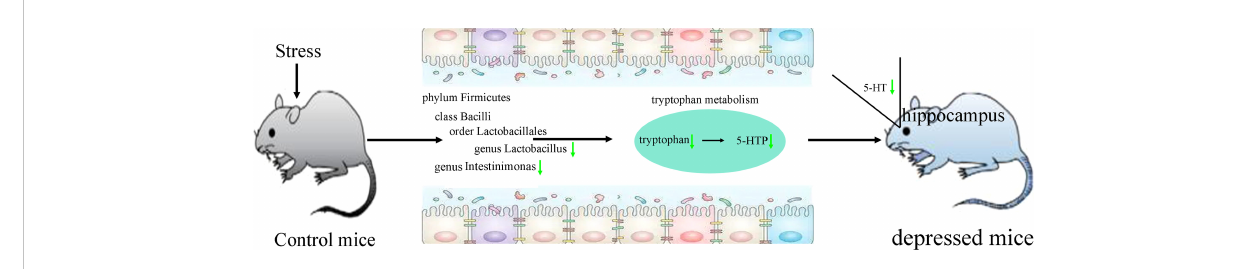
FIGURE 7 Tryptophan metabolism acting as a bridge in the crosstalk of gut and brain. 5-HTP, 5-hydroxytryptophan; 5-HT,